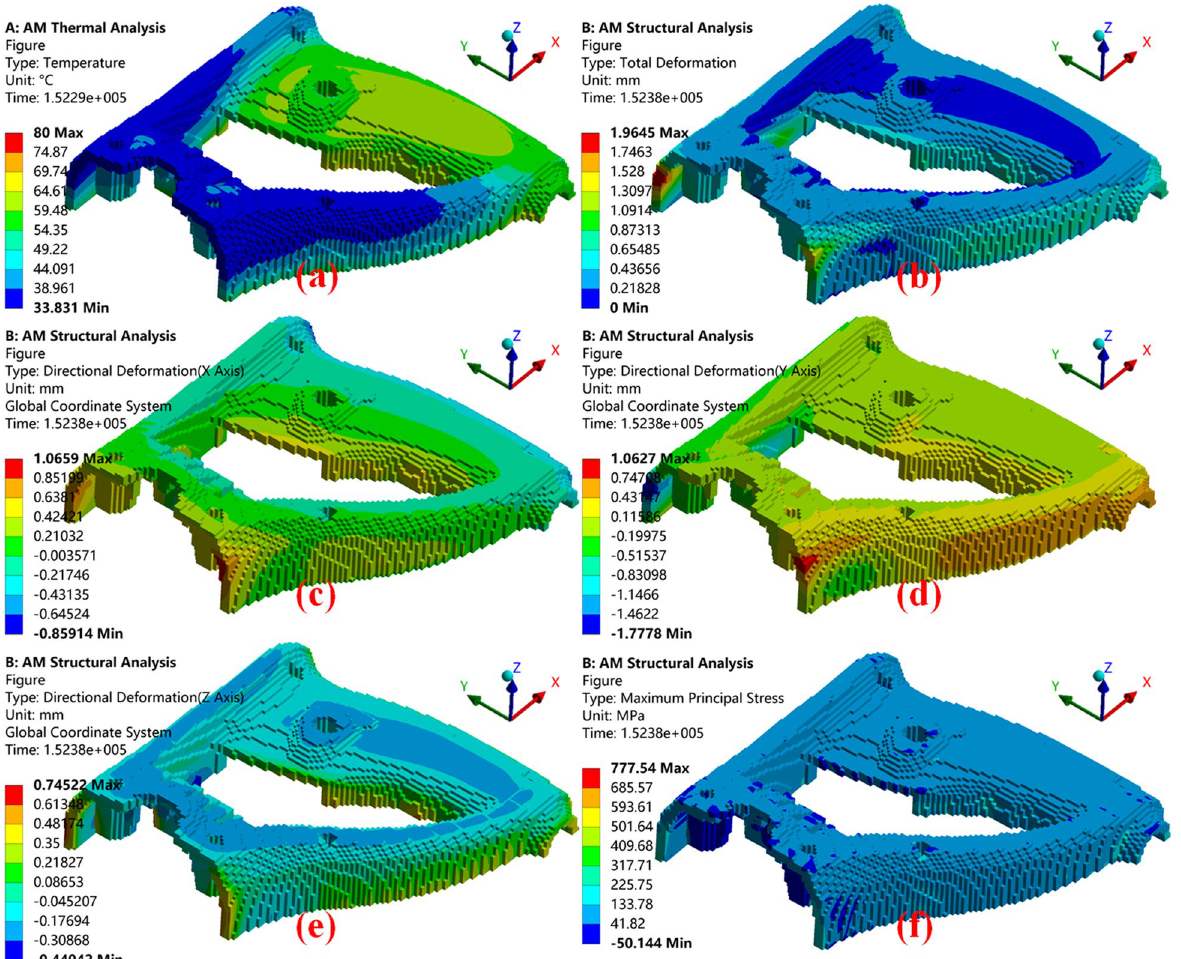
Fig. 11 Outcomes of FEA where a is the temperature distribution; b is the total deformation; and c , d , and e show the directional deformations along the X, Y, and Z axes, respectively; f shows the maximum principal stress